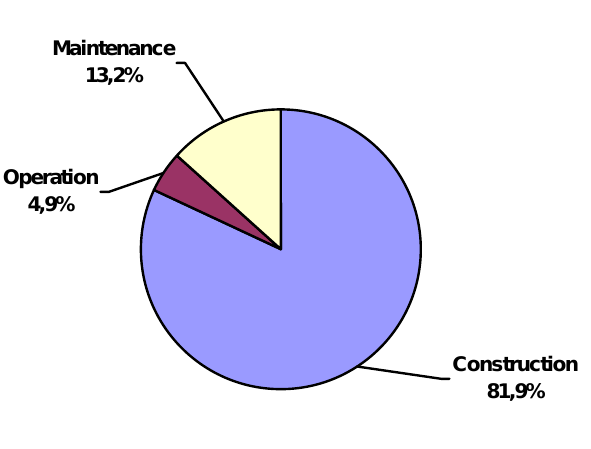
Figure 1. Shares of indirect energy associated with Swedish road infrastructure.